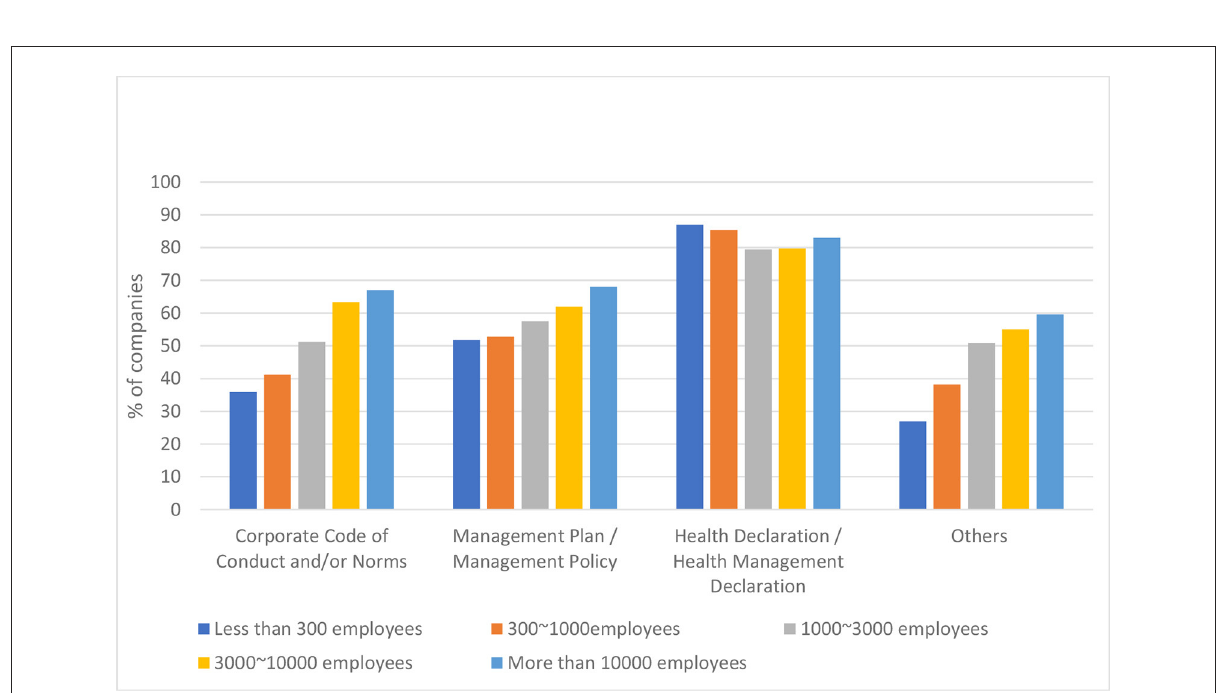
FIGURE4 The way H&PM is documented/stipulated in different scales of companies.